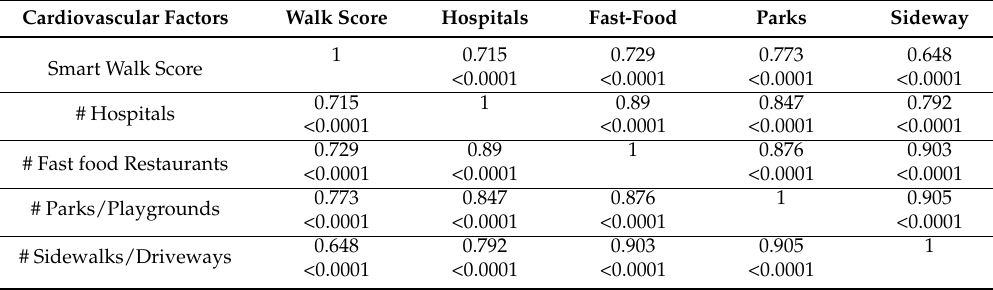
Table 2. Pearson Correlation Coefficient among cardiovascular factors.